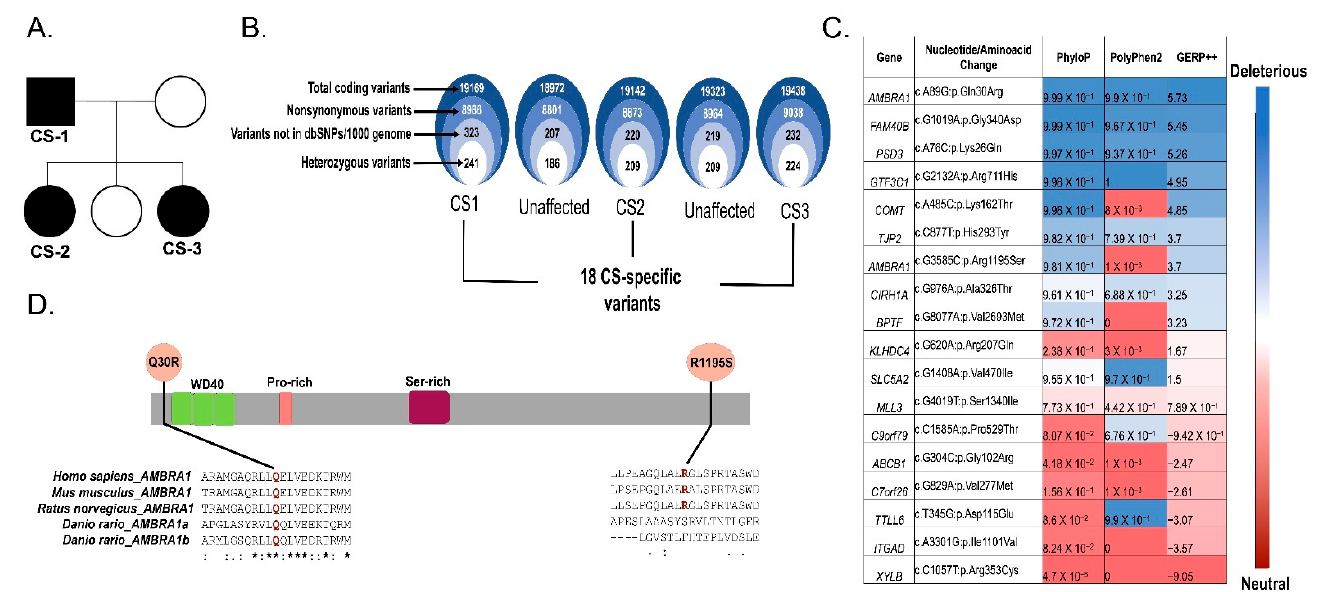
Figure 1. Identification of AMBRA1 Q30R as a possible candidate germline variant using whole exome sequencing data of CS patients. ( A ) Pedigree of CS family comprising three affected (CS1, CS2, CS3) and two unaffected individuals. ( B ) Schematic representation of variant filtering and prioritization performed on WES data of the 3 CS probands and 2 unaffected family members. ( C ) In silico pathogenicity prediction and conservation score of 18 CS-specific variants. ( D ) Schematic representation of the AMBRA1 protein showing WD domains and CS variants Q30R locating near the WD40 (Tryptophan-Aspartic Acid repeats) domain and R1195S locating at the C-terminal region. Clustal-W2 Multiple sequence alignments at the bottom showed evolutionary conservation of the affected residues (highlighted in red) among species. The symbol * (asterisk) below the multiple sequence alignment indicates positions with a single, fully conserved residue; the symbol: (colon) indicates conservation between groups of strongly similar properties and the symbol. (period) indicates conservation between groups of weakly similar properties.